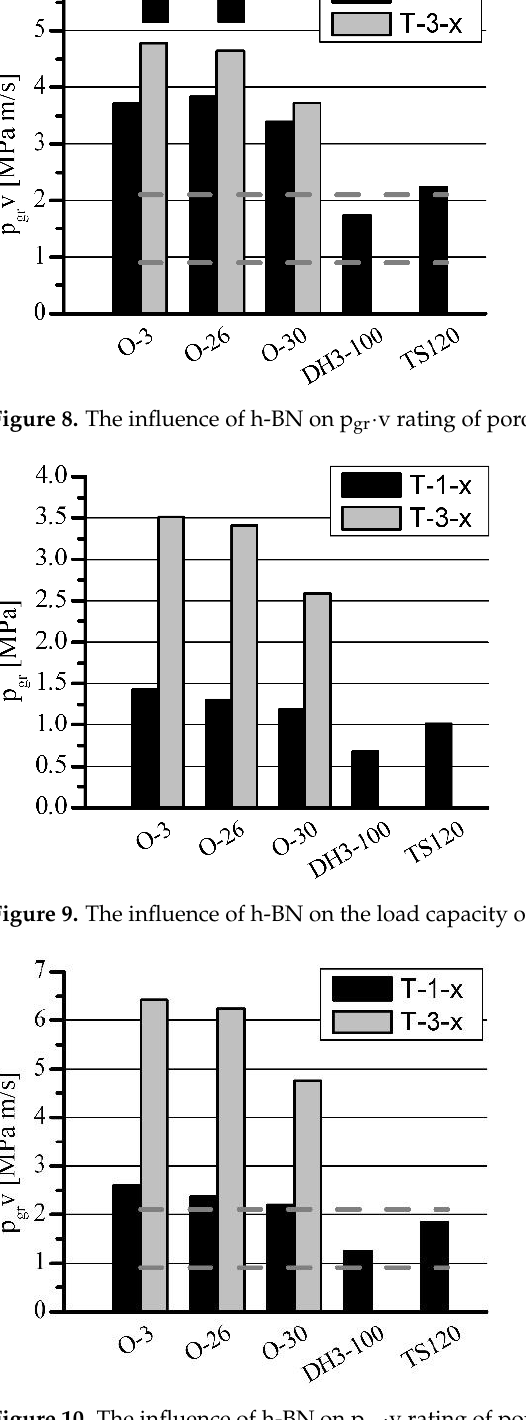
Figure 10. The influence of h-BN on p gr ·v rating of porous sleeves at n = 1400 rpm.